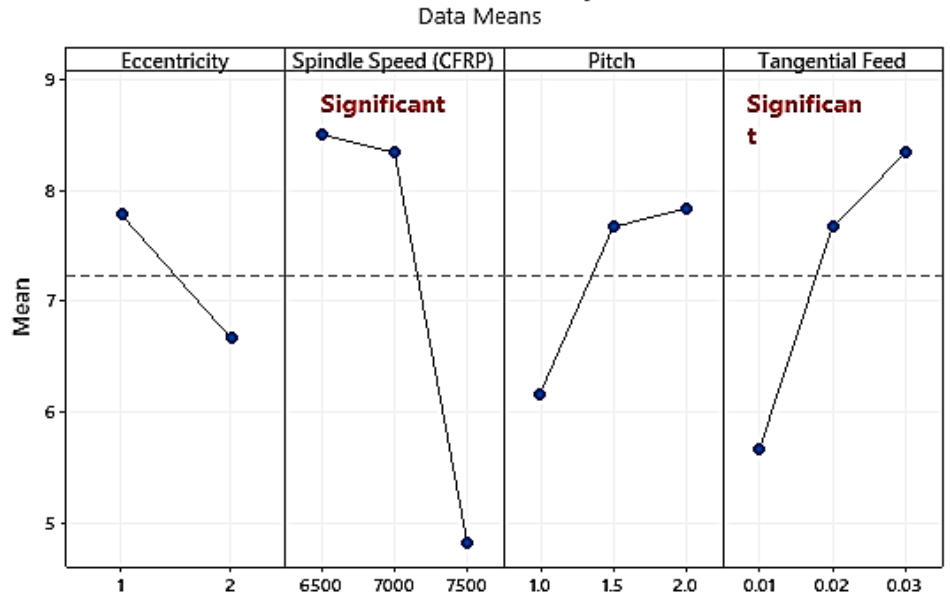
Figure 7. Main effects plot of circularity error in CFRP hole-making. Table 5. Analysis of variance of the circularity error of the CFRP.